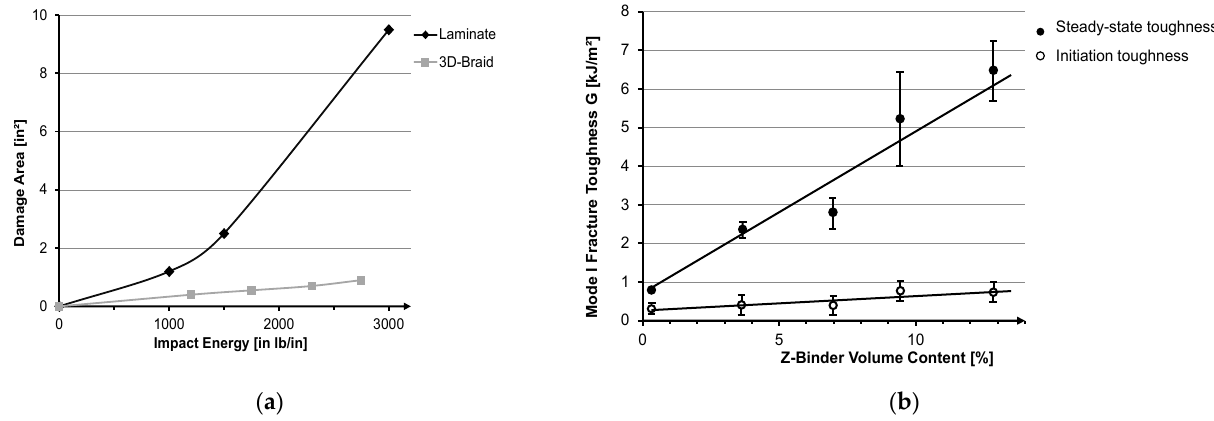
Figure 1. Energy required to initiate and propagate damage of 3D braids ( a ) [11]. Reprinted with permission from [11]. Copyright 2017 Elsevier. Effect of Z-binder yarn content on the initiation and steady-state fracture toughness values ( b ) [13]. Reprinted with permission from [13]. Copyright 2016